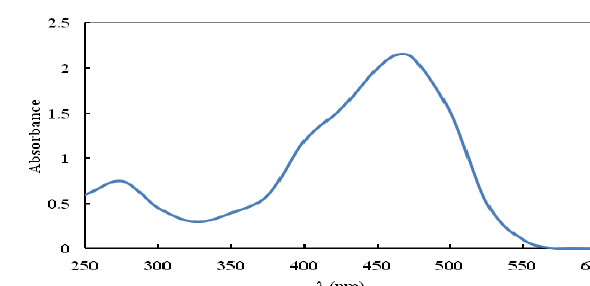
Fig. 3 . The UV-vis spectrum of methyl orange in